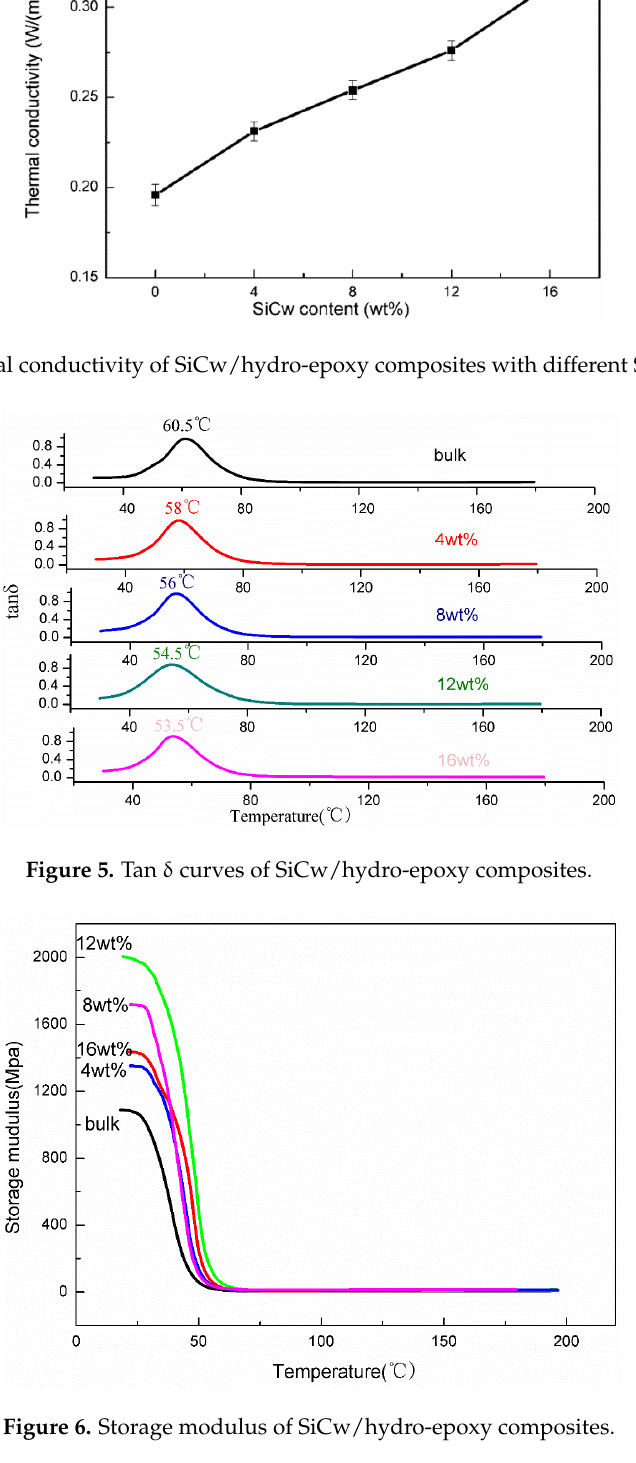
Figure 5. Tan δ curves of SiCw/hydro-epoxy composites. Figure 7. SEM of the SiCw/hydro-epoxy composites. 3.3. Shape Memory Property Analysis Through the DMA analysis, it can found that the SiCw has a passive effect on the shape fixity ratio. However, because the SiCw does not have shape memory behavior, there is no doubt that the SiCw has a negative effect on the shape recovery ratio of the SiCw/hydro-epoxy composite. In order to analyze the effect of SiCw content on the shape memory properties of the hydro-epoxy system, we tested the shape memory performance of the SiCw/hydro-epoxy composite. The results are shown in Table 1, revealing that, with the increase in SiCw content in the shape memory composites, the shape recovery speed slightly decreased, the shape fixity ratio improved, and the shape recovery ratio significantly decreased. However, the shape recovery ratio of all samples was more than 95%, which indicates that the SiCw/hydro-epoxy composite is an excellent shape memory polymer composite. Figure 8 shows the shape memory process of a specimen with 8 wt % SiCw. Starting from the original shape, the specimen is deformed into a U shape in the oven. Upon cooling under load, the deformed temporary shape is fixed. Then, placing the specimen in the 56 °C oven, full recovery was observed after only 75 s.